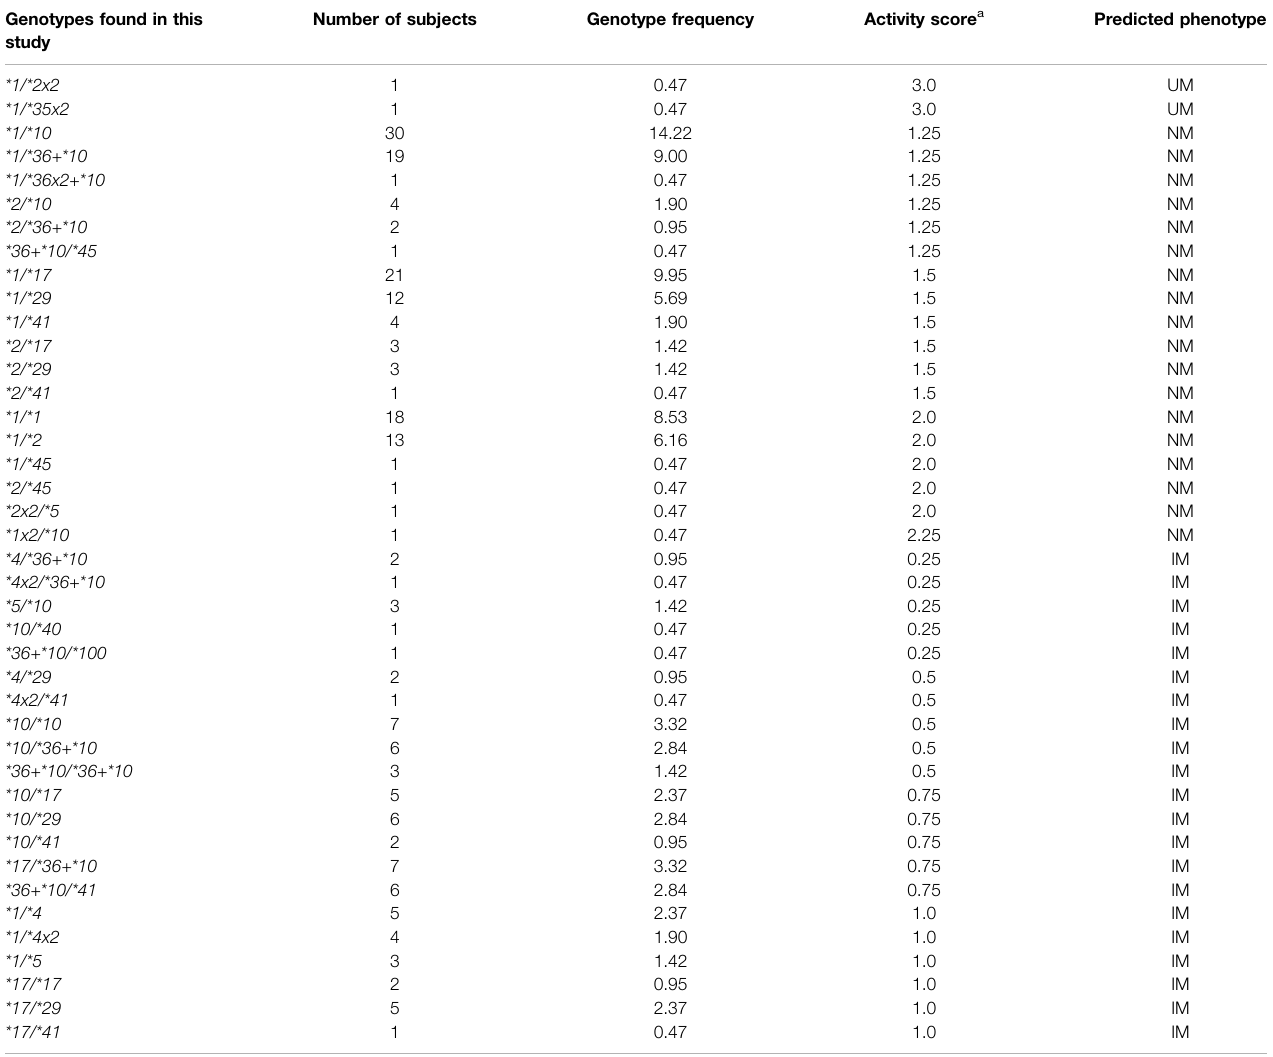
TABLE 2 | CYP2D6 genotype frequencies and predicted phenotypes in the Madagascar study population § . Genotypes found in this